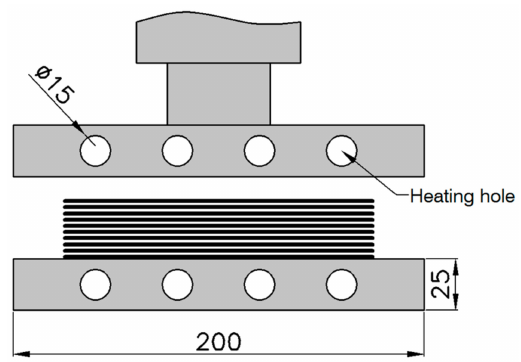
Figure 1. Schematic diagram of the equipment for fabricating carbon fiber-reinforced plastic (CFRP) using 10 pre-impregnated composite fibers (prepregs) (unit: mm). Table 1. Mechanical properties of CFRP prepreg (CF3327EPC, HANKUK CARBON) [16].